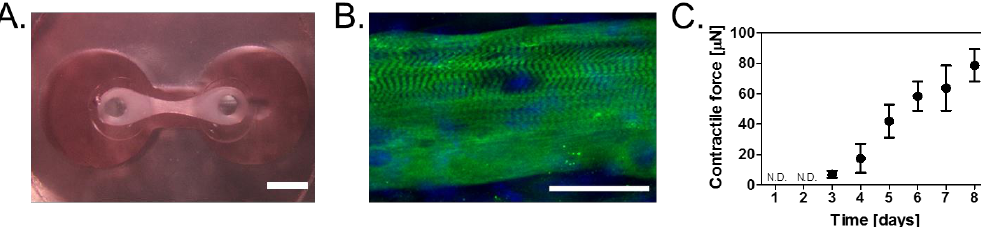
Figure 2. ( A ) Top view image of a skeletal muscle tissue constructed on the device. The scale bar reads 1 mm; ( B ) Fluorescence micrograph of a myotube in the skeletal muscle tissue on the device, which was cultured in DM for six days. Here, green indicates fast MHC and blue indicates the nuclei. The scale bar reads 50 µm; ( C ) Time course of contractile force after culturing in DM. Results represent mean ± SD ( n = 3). N.D. indicates not detected.